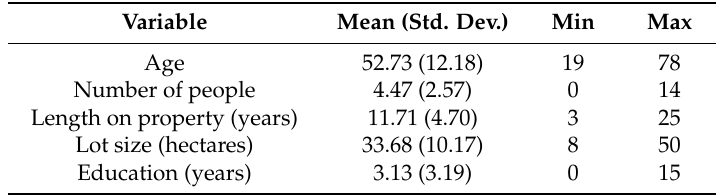
Table 1. General characteristics of households ( N = 104).